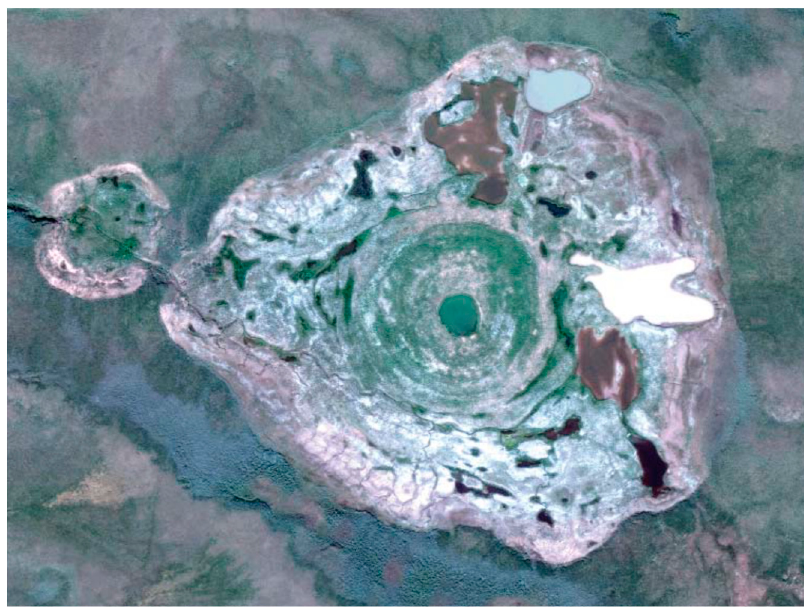
Figure 4. Dried lake with a gas emission crater in the center. Satellite image of 17 July 2013 (number on the map: 4) [9].